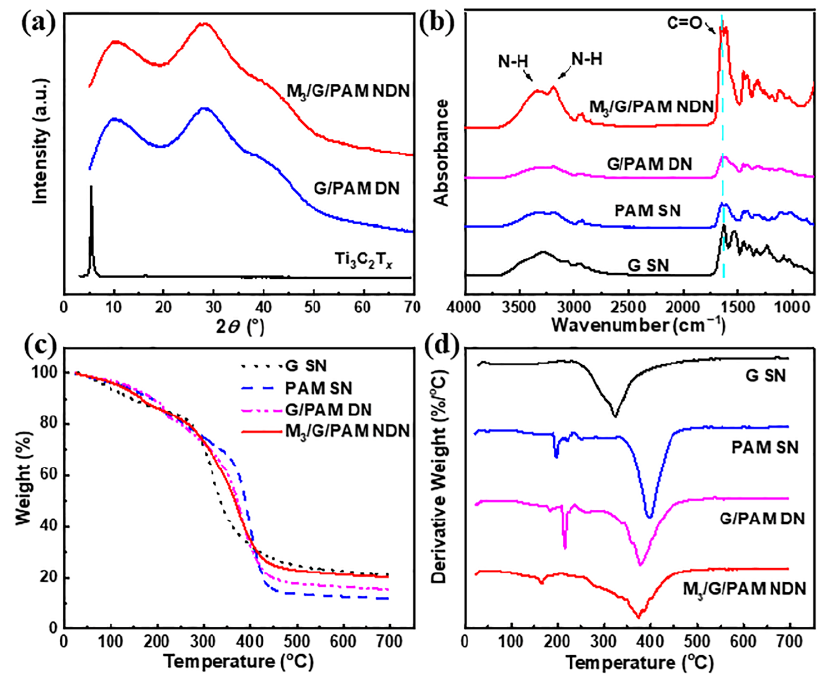
Figure 4. ( a ) XRD spectra of few-layered Ti 3 C 2 T x , G/PAM DN gel, and M 3 /G/PAM NDN gel; ( b ) FT-IR spectra and ( c ) TGA curves and ( d ) DTG curves of G SN gel, PAM SN gel, G/PAM DN gel, and M 3 /G/PAM NDN gel.